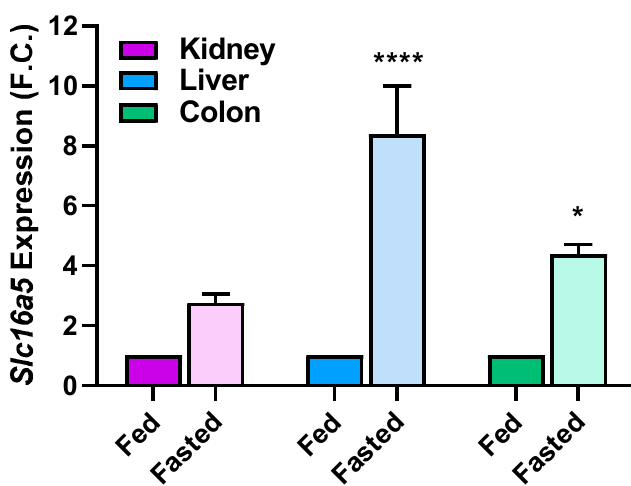
Figure 5. mRNA expression of Slc16a5 (Mct6) in fed and fasted diets in Mct6 +/+ mice. All gene expression data were normalized to a housekeeping gene ( Hprt ). Data were plotted as mean fold change ± standard error of the mean (SEM) (N = 4–5 mice, 28–30 weeks of age). Gene expression was normalized to fed dieting state for each tissue (**** p < 0.0001, * p < 0.05, compared to the fed dieting state for each tissue).